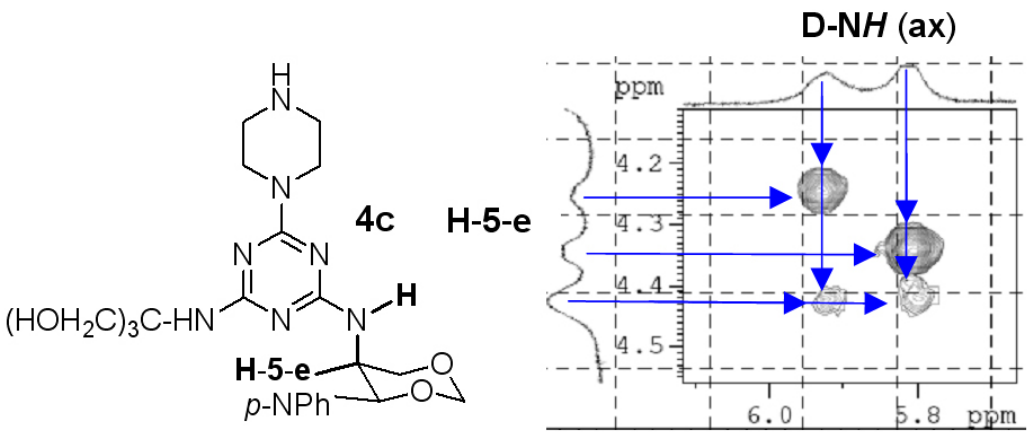
Figure 3. Detail from 2D- 1 H, 1 H-COSY Chart of compound 4c (on 500 MHz time scale in [D